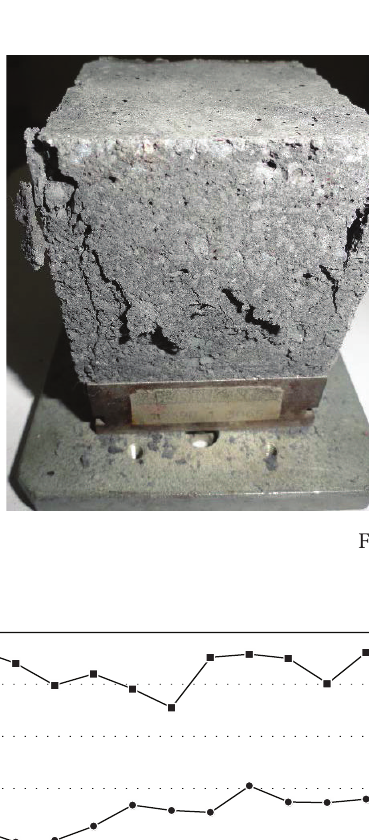
Figure 9: Satisfactory failures (BS EN 12390-3 : 2002).